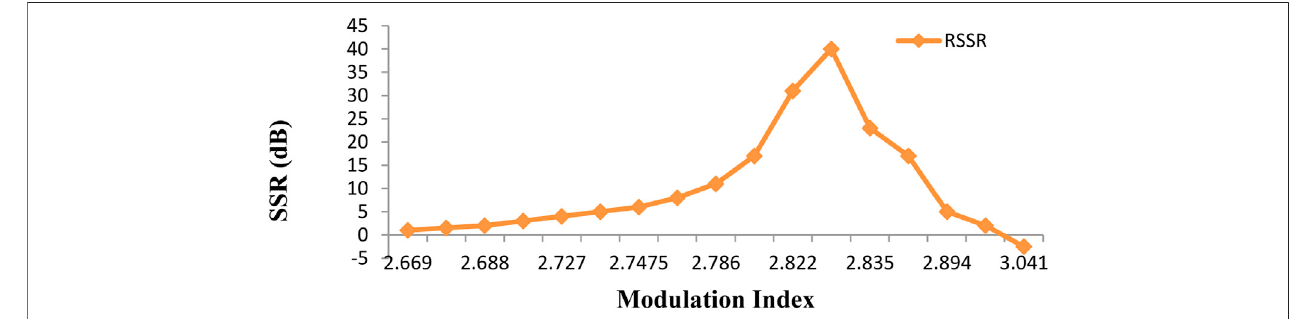
FIGURE 10 | RSSR variation with the modulation index.